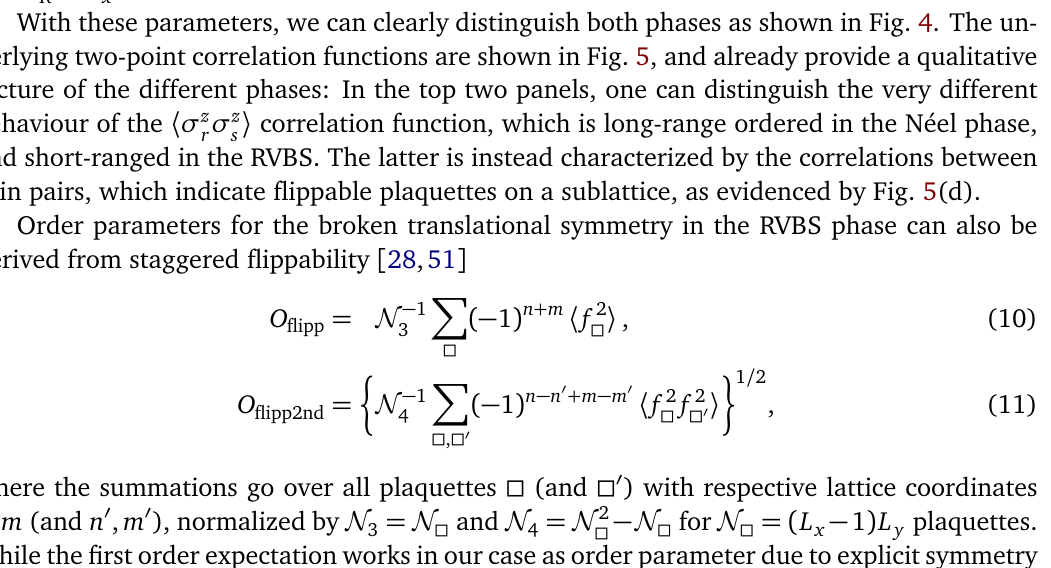
Figure 5: Spin-correlations visualized for a section of a 30 × 10 lattice in Néel- ( λ = − 0.6, left panels [ (a),(c) ] ) and RVBS phase ( λ = 0.7, right panels [ (b),(d) ] ). Top panels [ (a),(b) ] show spin-spin correlations 〈 σ z while bottom panels [ (c),(d) ] show spin pair-pair correlations in O and grey dots (lines for pairs) represent negative and positive expectation values of the correlation to the reference (black), their filled area (line-width for pairs) is proportional to the correlation strength (reference =